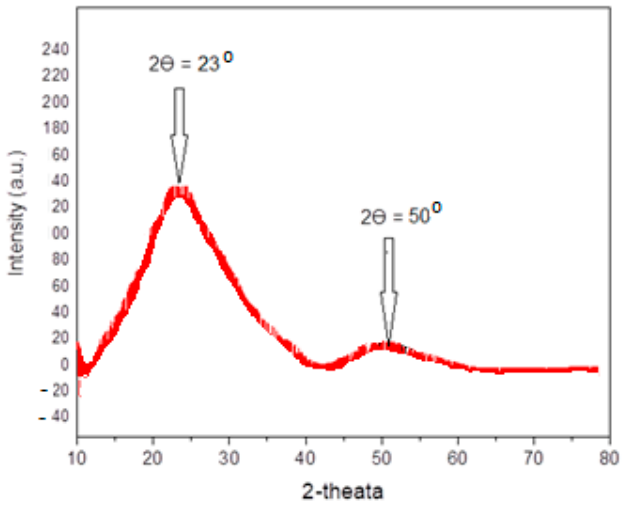
Figure 9. XRD patterns of the complex Ia/II upon cooling from the isotropic liquid state.